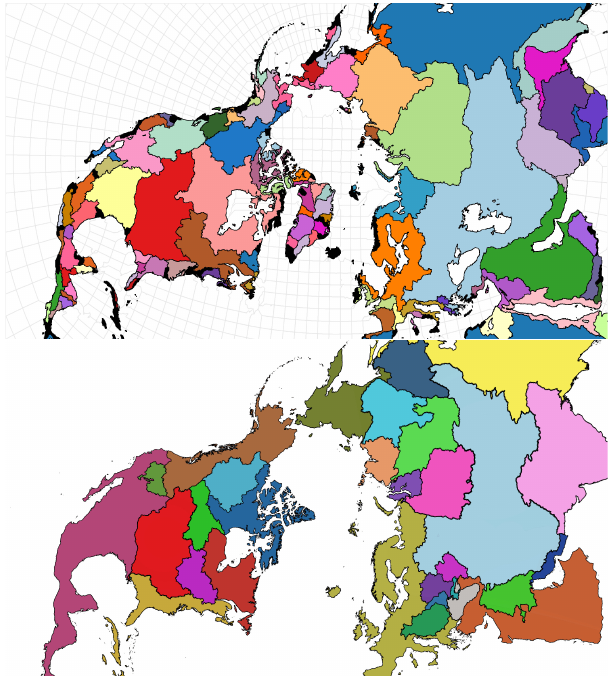
Fig. 6. Drainage basins for the present-day topography derived with CRM (a) , where each colour represents a region that drains into the same ocean grid box (shown in grey over the ocean). (b) Level one drainage delineation from the HYDRO1k data